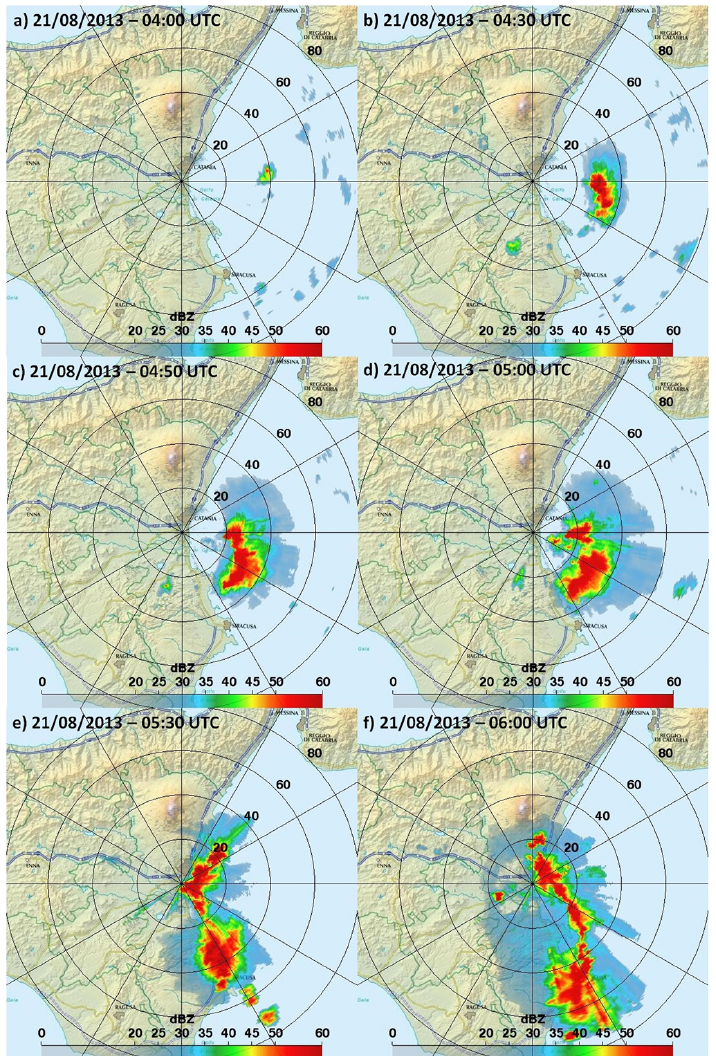
Figure 10. Vertical maximum intensity maps as retrieved on 21 August 2013 at 04:00, 04:30, 04:50, 05:00, 05:30 and